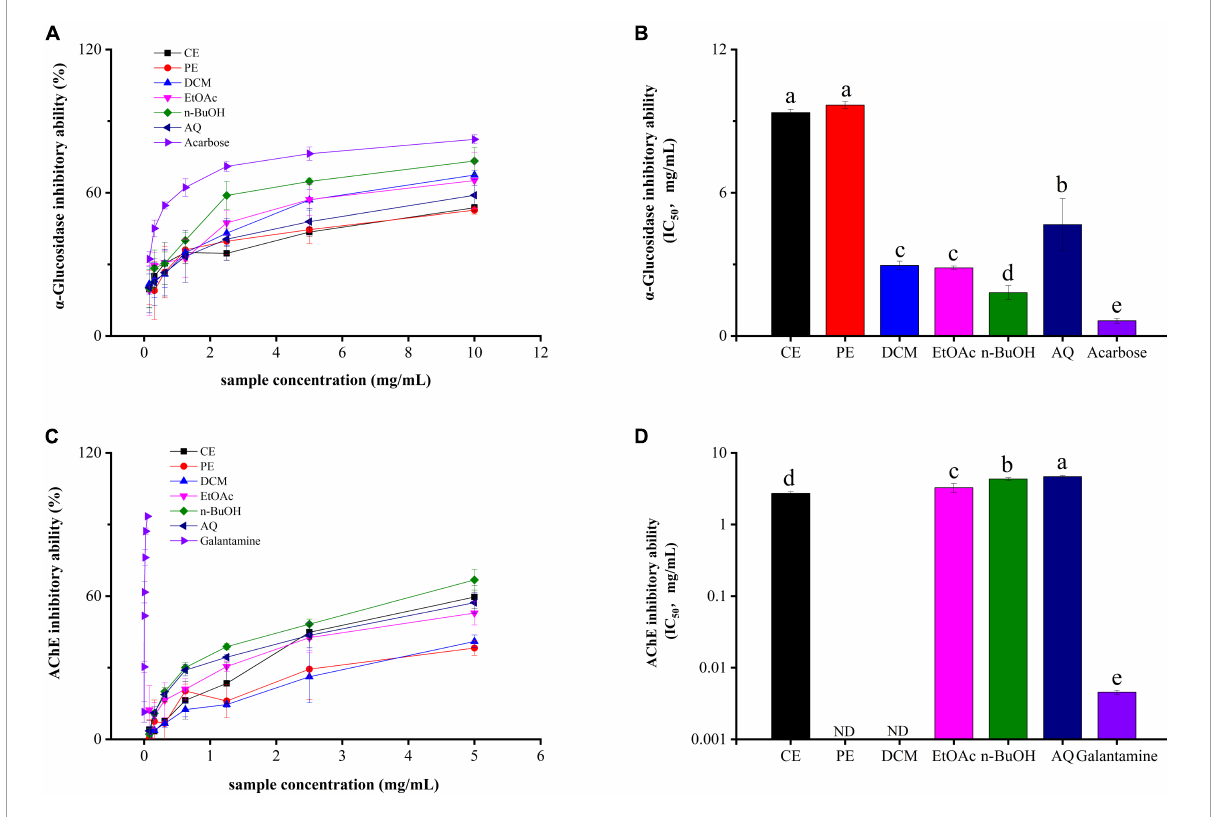
FIGURE3 The α -glucosidase (A,B) and acetylcholinesterase (C,D) inhibitory activities of BCF crude extract and its